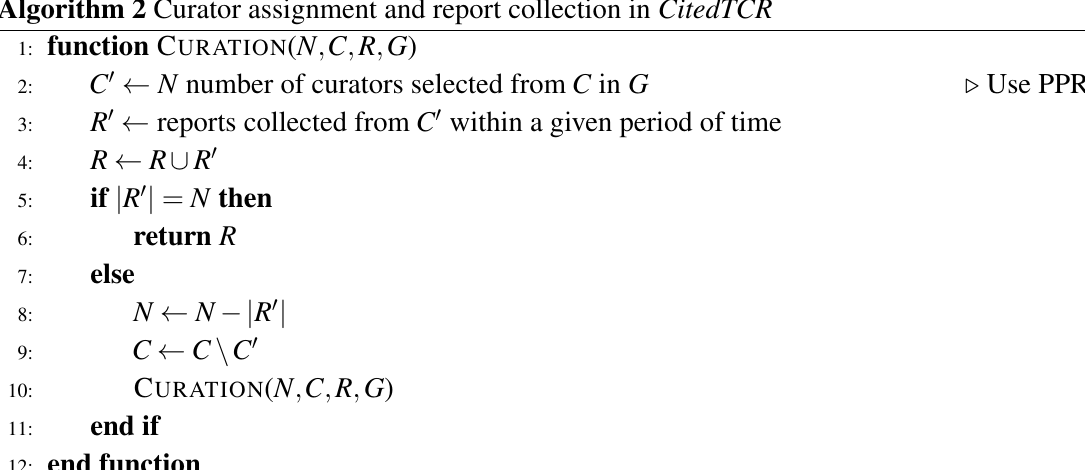
Algorithm 2 Curator assignment and report collection in